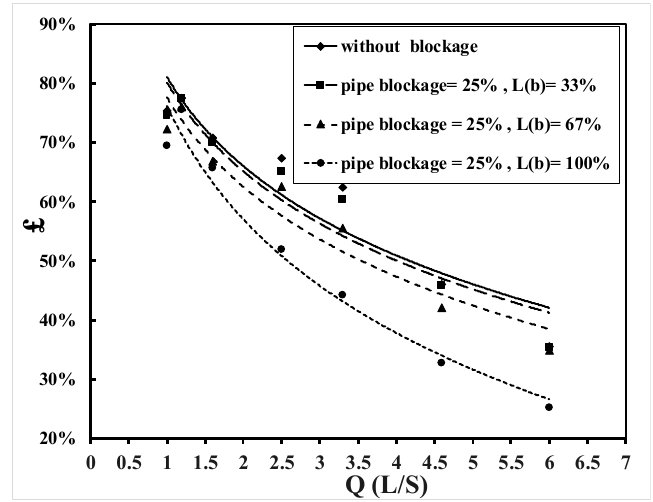
Figure 15. ( A ) The blockage along main pipe length and ( B ) end pipe blockage.